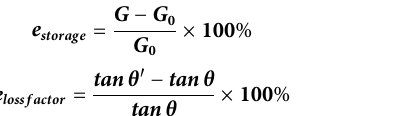
Figure 2A. This testing clamp is consisted of a magnetic induction frame (low-carbon steel), cylinder core (low-carbon steel), cooper coils (self-adhesive coils), piston rod (low-carbon steel) and top cover plate (low-carbon steel), as illustrated in Figure 2B. In addition, the steel frame is fastened on the DMA base and the piston rod is connected to the aluminum loading bearer. The external magnetic is applied by a DC-regulated power supply and controlled by adjusting the coil current. The MRE specimens are cut into small cylinders with a size of 9 mm diameter and 2 mm height for DMA measurements. The dynamic properties dependent on the frequency of the MRE specimens are investigated under a static load of 2 N and dynamic amplitude of 2 μ m from 1 to 100 Hz at room temperature. Frequency